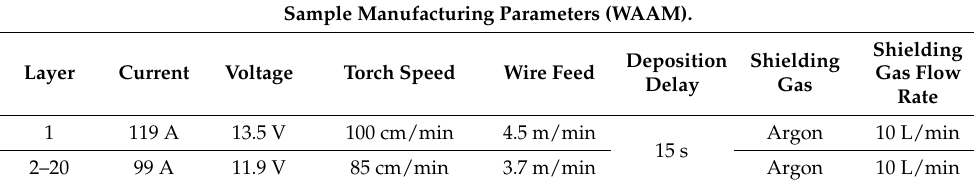
Table 1. Table 1. Sample Manufacturing Parameters (WAAM) . Sample Manufacturing Parameters (WAAM). Table 1. Sample Manufacturing Parameters (WAAM).